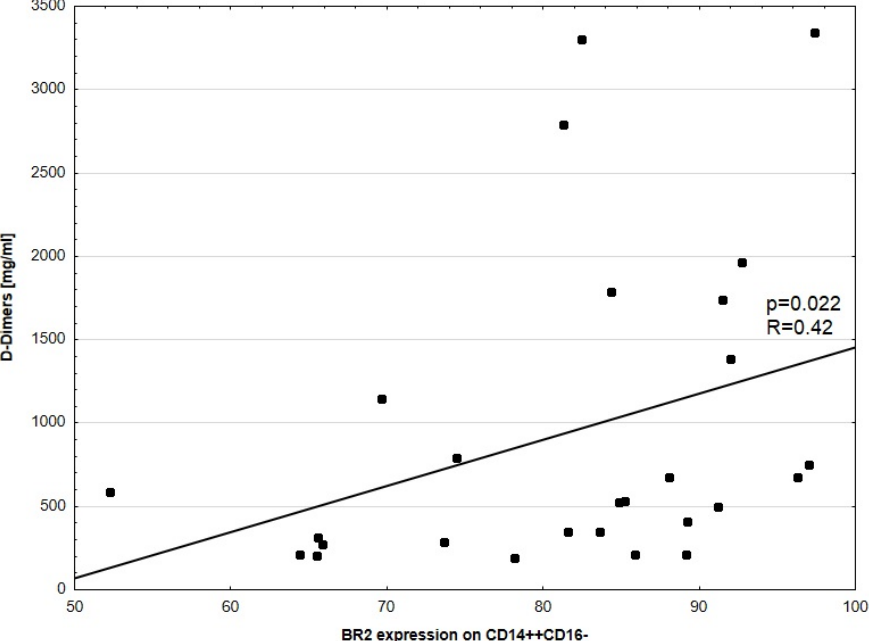
Figure 3. Correlation between D-Dimer concentration and BR2 expression in CD14 ++ CD16 − cells . Each dot represents one patient.